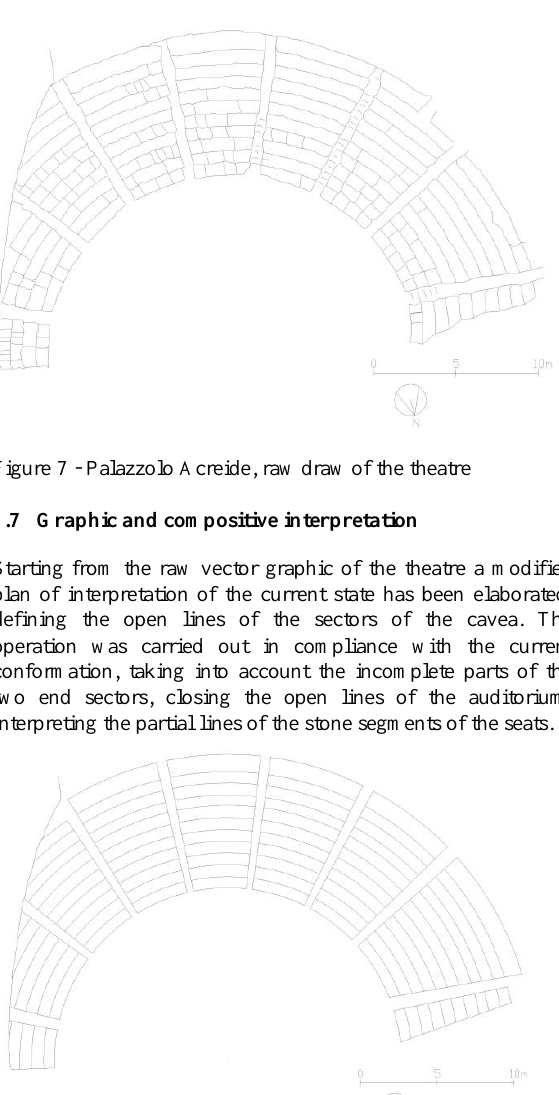
Figura 6 – Zephyr: tracciamento della polilinea sul modello 3D